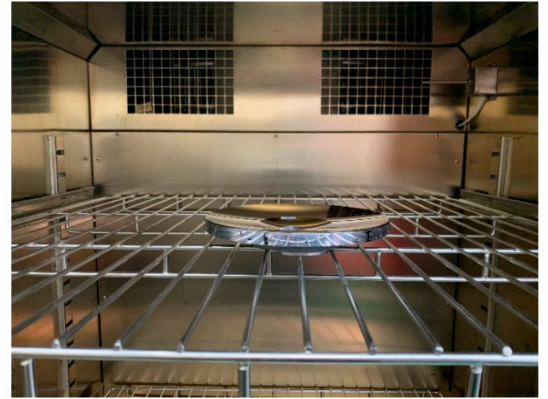
Figure 18. The AM mirror in the test